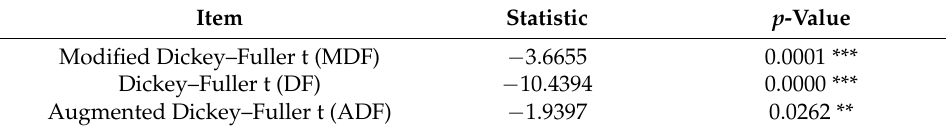
Table 7. Cointegration test.